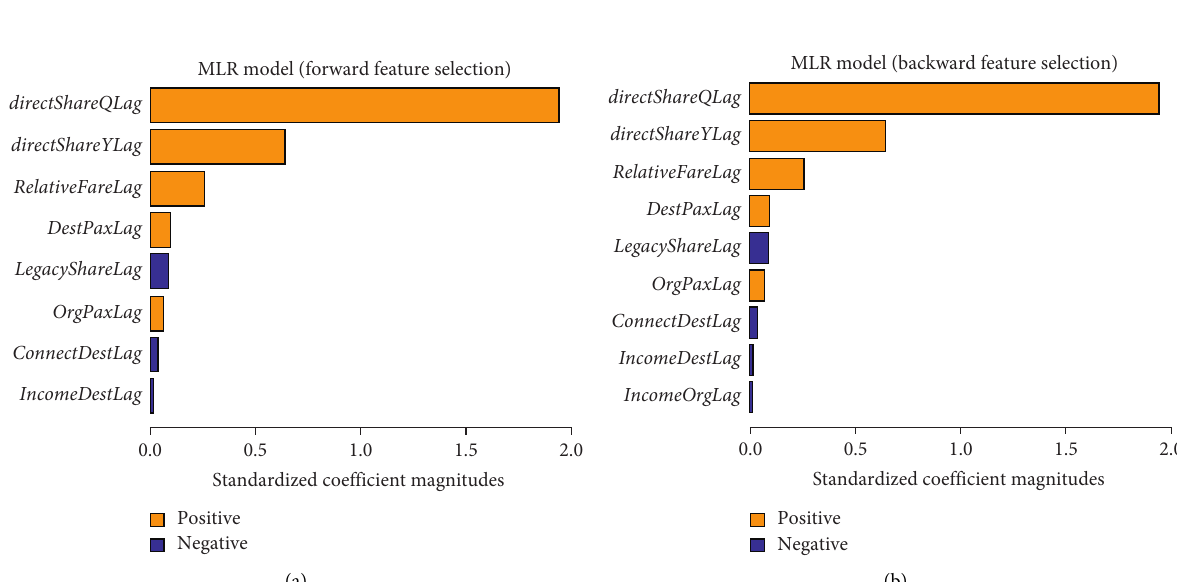
Figure 4: Forward and backward feature selection process.